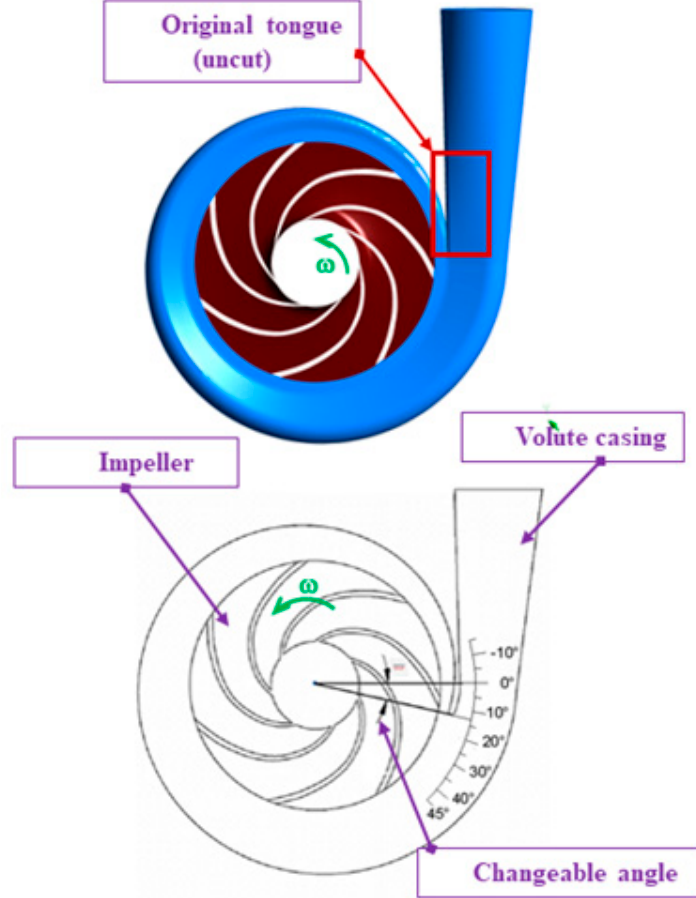
Figure 1. The designed volute casing of the centrifugal pump [21].